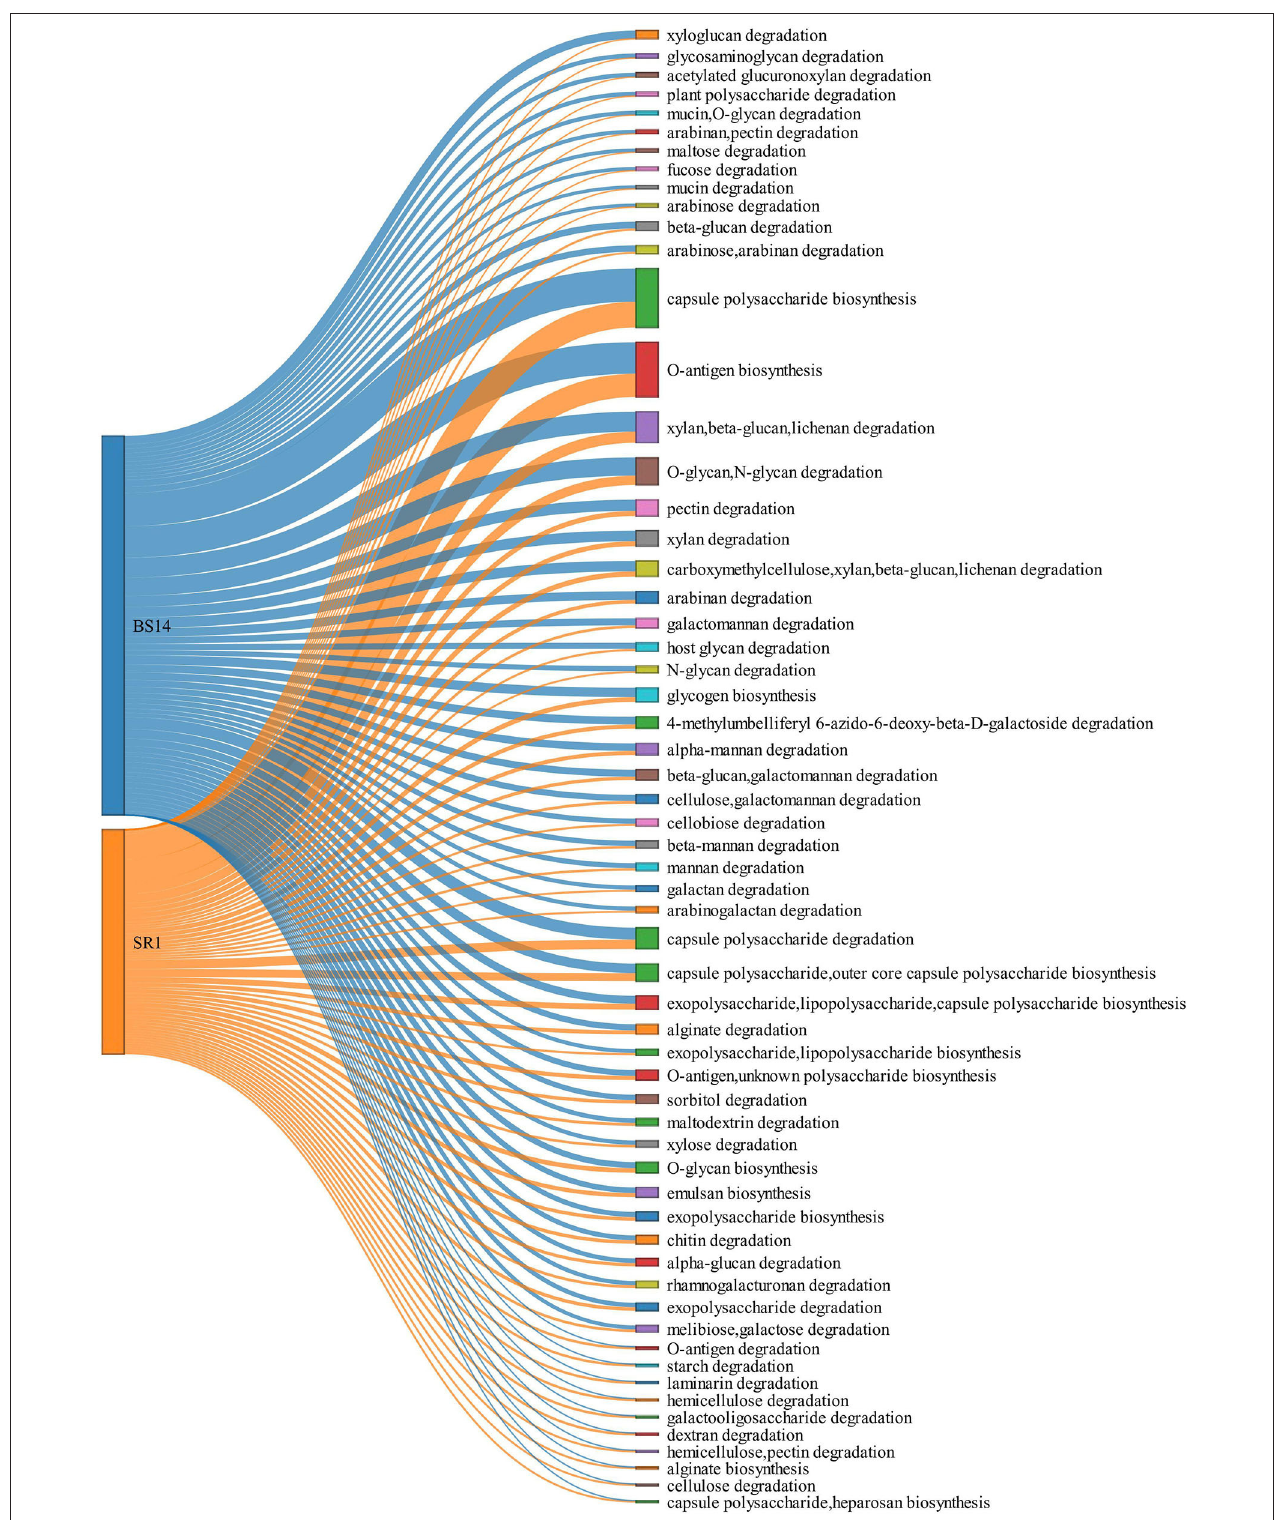
FIGURE 10 | Sankey plot elaborating the total PULDB functions of BS14 and SR1.